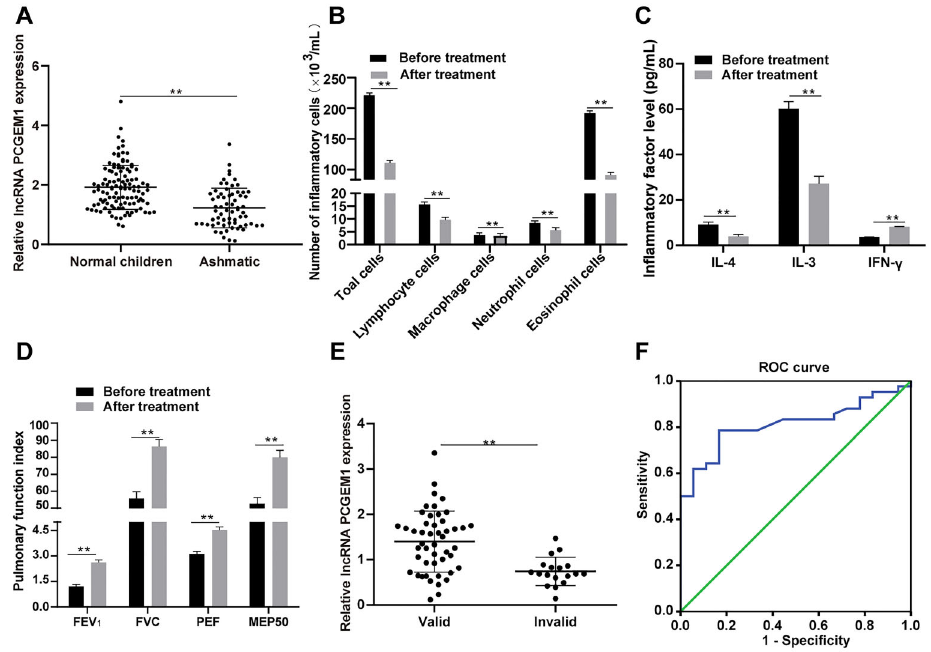
Figure 1. Montelukast sodium exerts inhibitory effects on in fl ammation and promotive effect on pulmonary function in cough-variant asthma (CVA) children. A , RT-qPCR determination of lncRNA prostate cancer gene expression marker 1 (PCGEM1) expression in peripheral blood lymphocytes of CVA children (n=60) and normal children. B , The number of total peripheral blood in fl ammatory cells, lymphocytes, macrophages, neutrophils, and eosinophils in CVA children. C , The levels of in fl ammatory mediators in peripheral blood of CVA children measured by ELISA. D, Evaluation of pulmonary function index of CVA children: forced expiratory volume in fi rst second